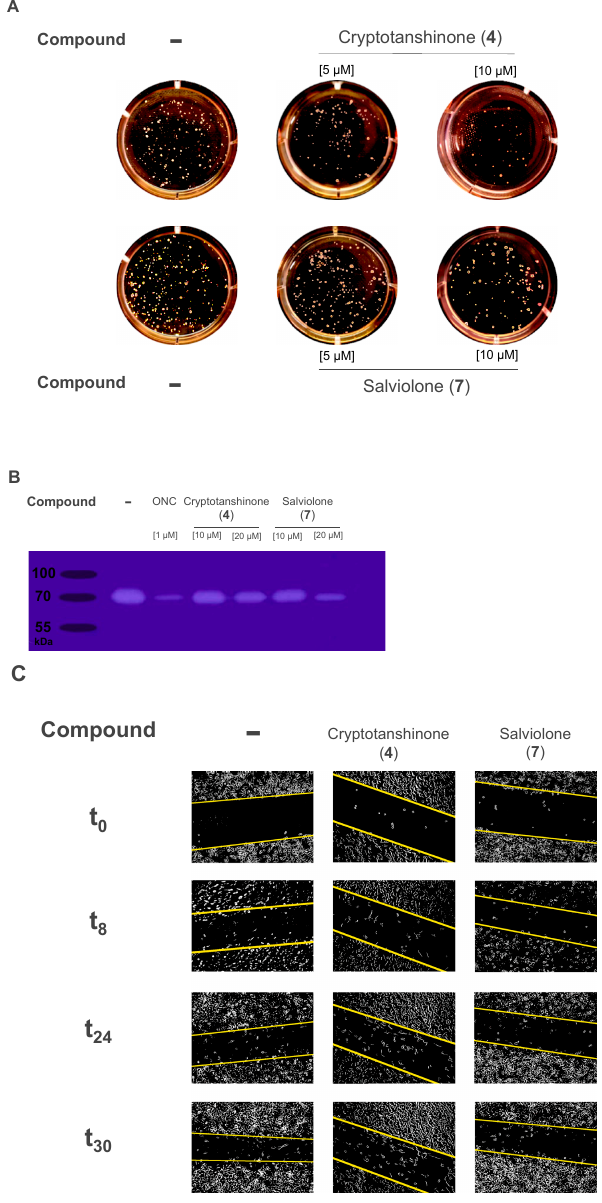
Figure 6. Cryptotanshinone ( 4 ) and salviolone ( 7 ) effect on colony formation, digestion of extracellular matrix, and migration. ( A ) A colony formation assay of A375 melanoma cells with 5 and 10 µ M cryptotanshinone ( 4 ) or salviolone ( 7 ) cultured for 21 days in soft agar. ( B ) A gel zymography assay showing the ability of cryptotanshinone ( 4 ) or salviolone ( 7 ) to inhibit the metalloproteinase (MMP)2 gelatinase activity in A375 cells. ( C ) A wound healing assay attesting the inhibition of cell mobility with 20 µ M cryptotanshinone ( 4 ) in the A375 cell line. Images were captured with Zeiss Axio Vert (10 × ) at time 0, 8, 24, and 30 h after the administration of each compound. For A, B, and C, the images reported a representative picture of three independent